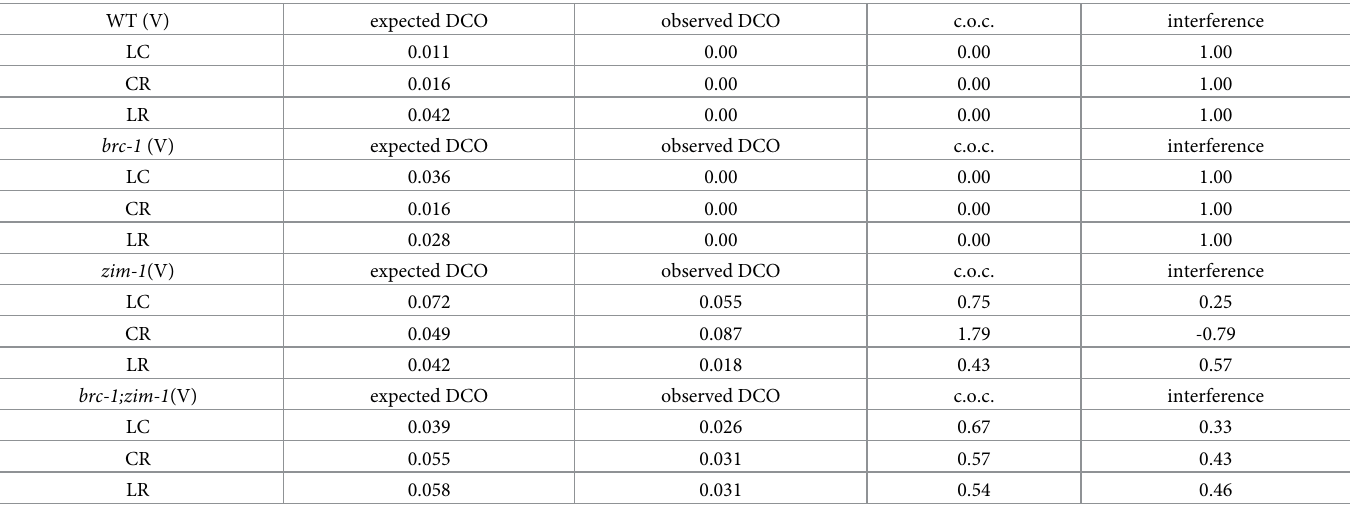
Table 1. Crossover interference on chromosome V .